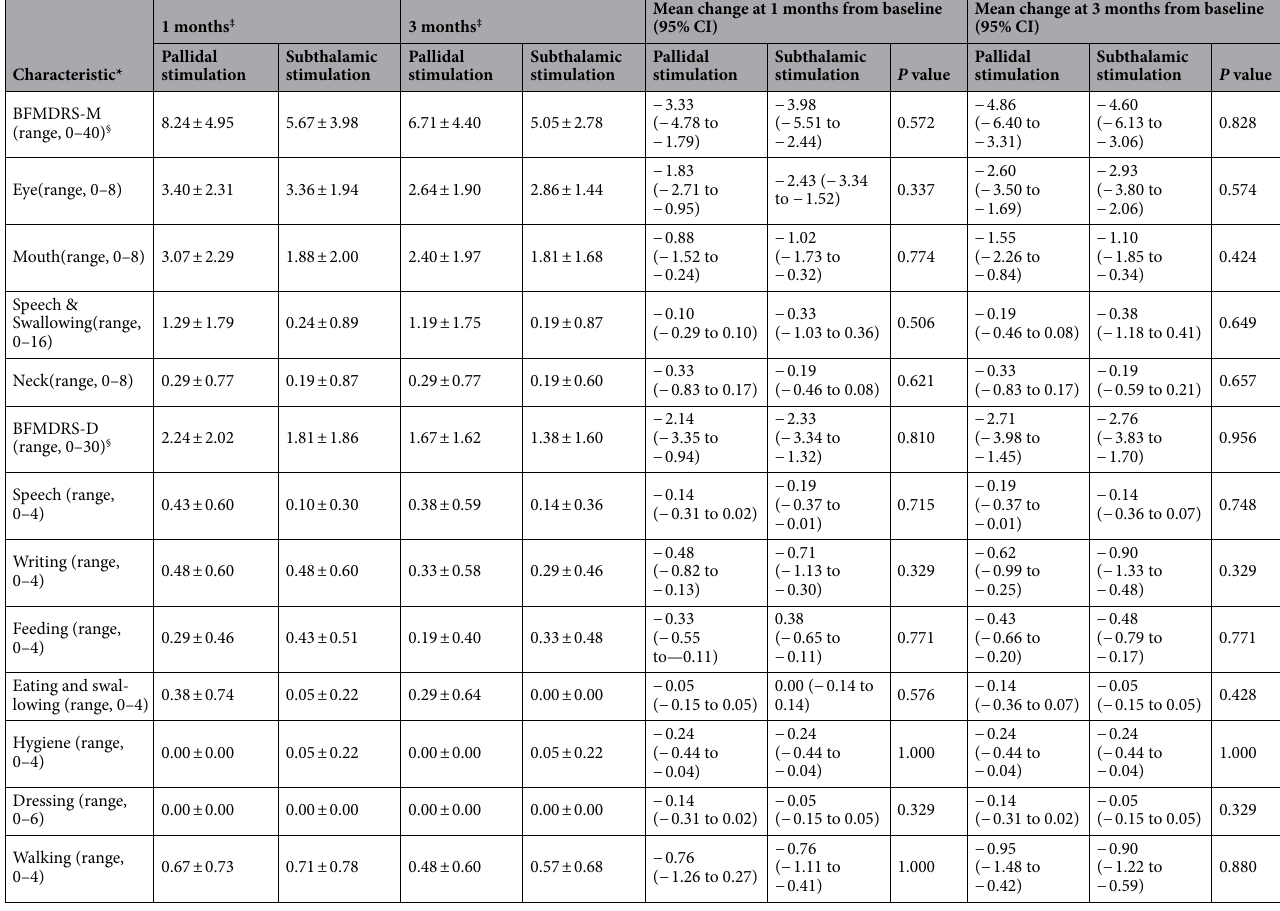
Table 2. Primary Outcome at 1 and 3 Months. *Plus–minus values are means ± SD. ‡ Assessments with DBS on. § A higher score indicates worse